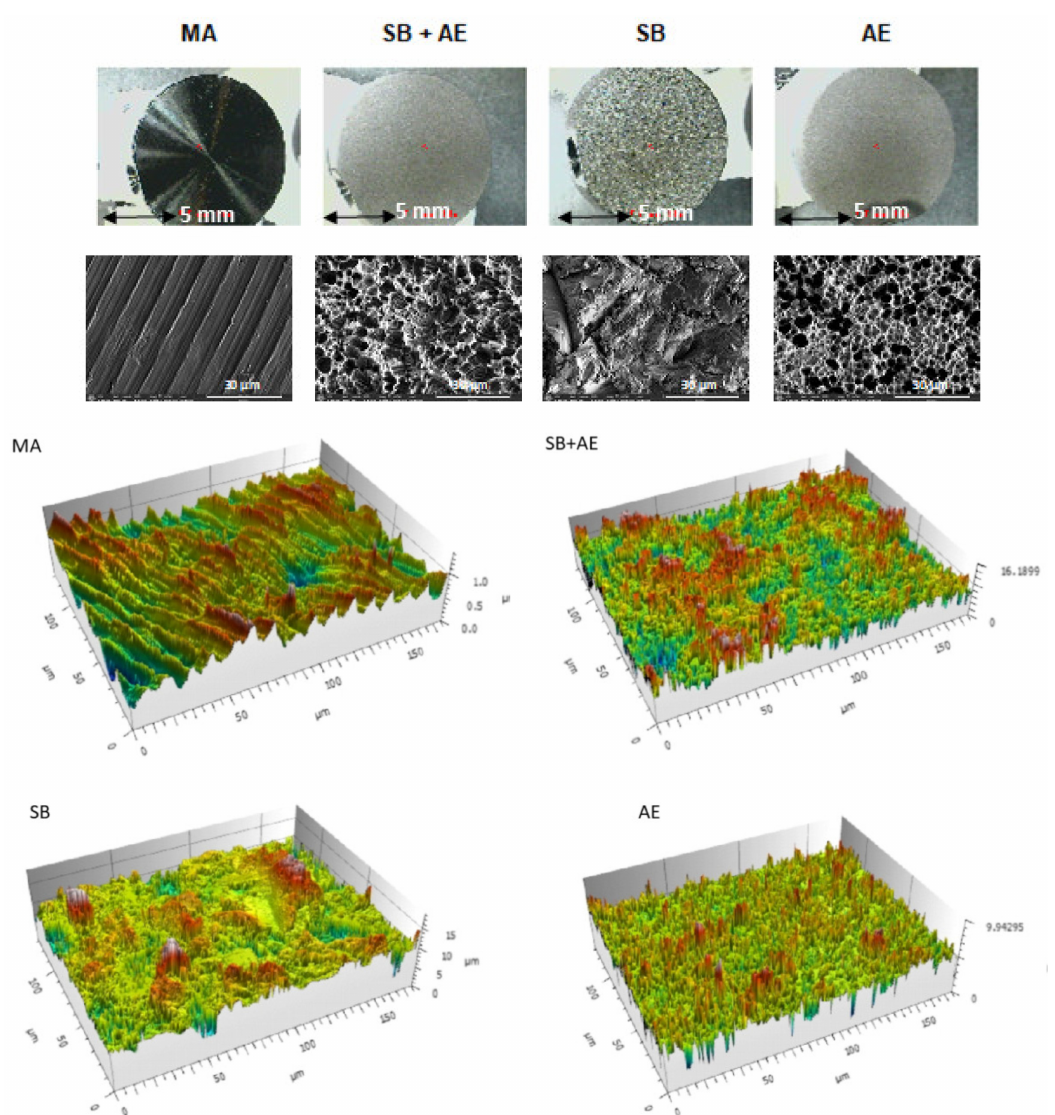
Figure 1. Macroscopic surfaces, topography observed using a scanning electron microscope and perfilometry of the different surfaces obtained (MA: machined; SB+AE: sand blasted with acid etching; SB: sand blasted; and AE: acid etched